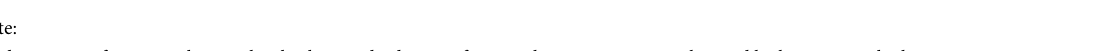
Table 5 reports the PSM results. The nearest neighbor matching results showed that the life satisfaction score of the treatment group was 0.205 units higher than that of the control group, and it was significant at the 10% level. Comparing the results of kernel matching and radius matching, the three results were highly similar and consistent with the original conclusion. Thus, political participation still had a significant impact on urban residents’ life satisfaction after the self-selection problem had been solved.